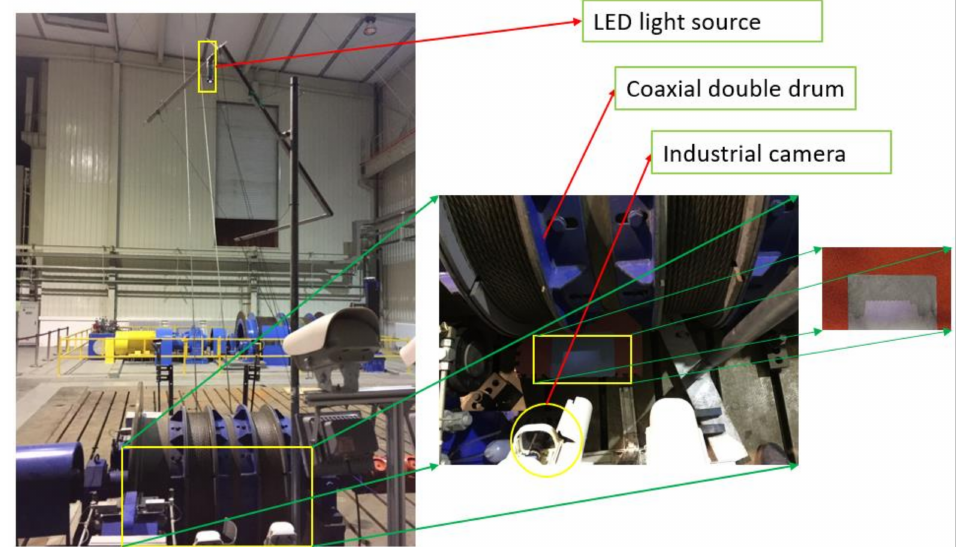
Figure 19. Hardware setting diagram of the drum rope guiding detection for the ultra-deep well simulation test